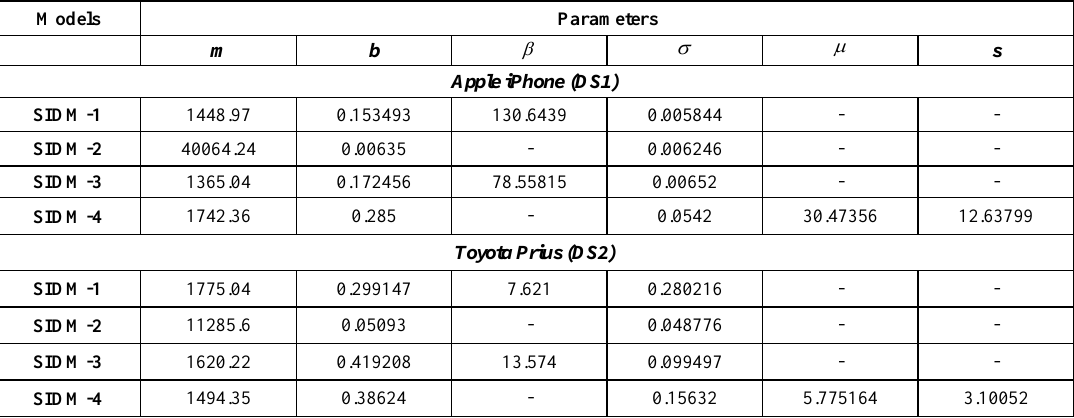
Table 2. Parameter estimation results